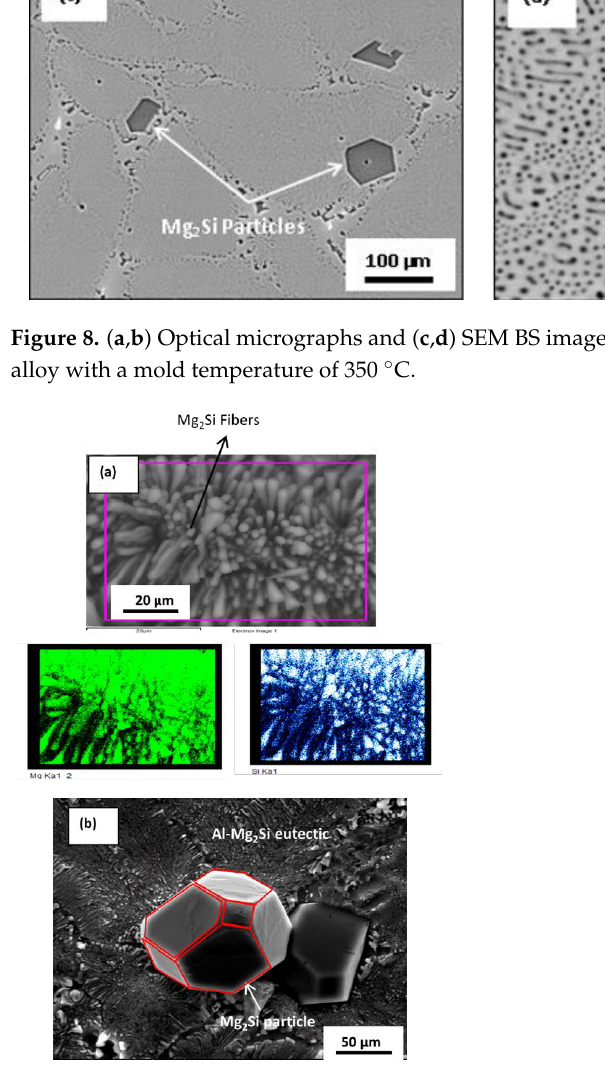
Figure 10 . ( a , b ) SEM SE images taken from the deep-etched sample, which confirm the fibrous mor- phology of Mg 2 Si in the Al-13.1 wt.% Mg 2 Si-200 ppm P alloy along with ( c ) the EDS spectrum of elements from the selected point, as marked in ( b ). Figure 11. ( a ) bright-field TEM image showing the Al-Mg 2 Si eutectic at a lower magnification, ( b ) shows the faceted eutectic Mg 2 Si globules with a diameter of ~0.4 μm at a higher magnification and